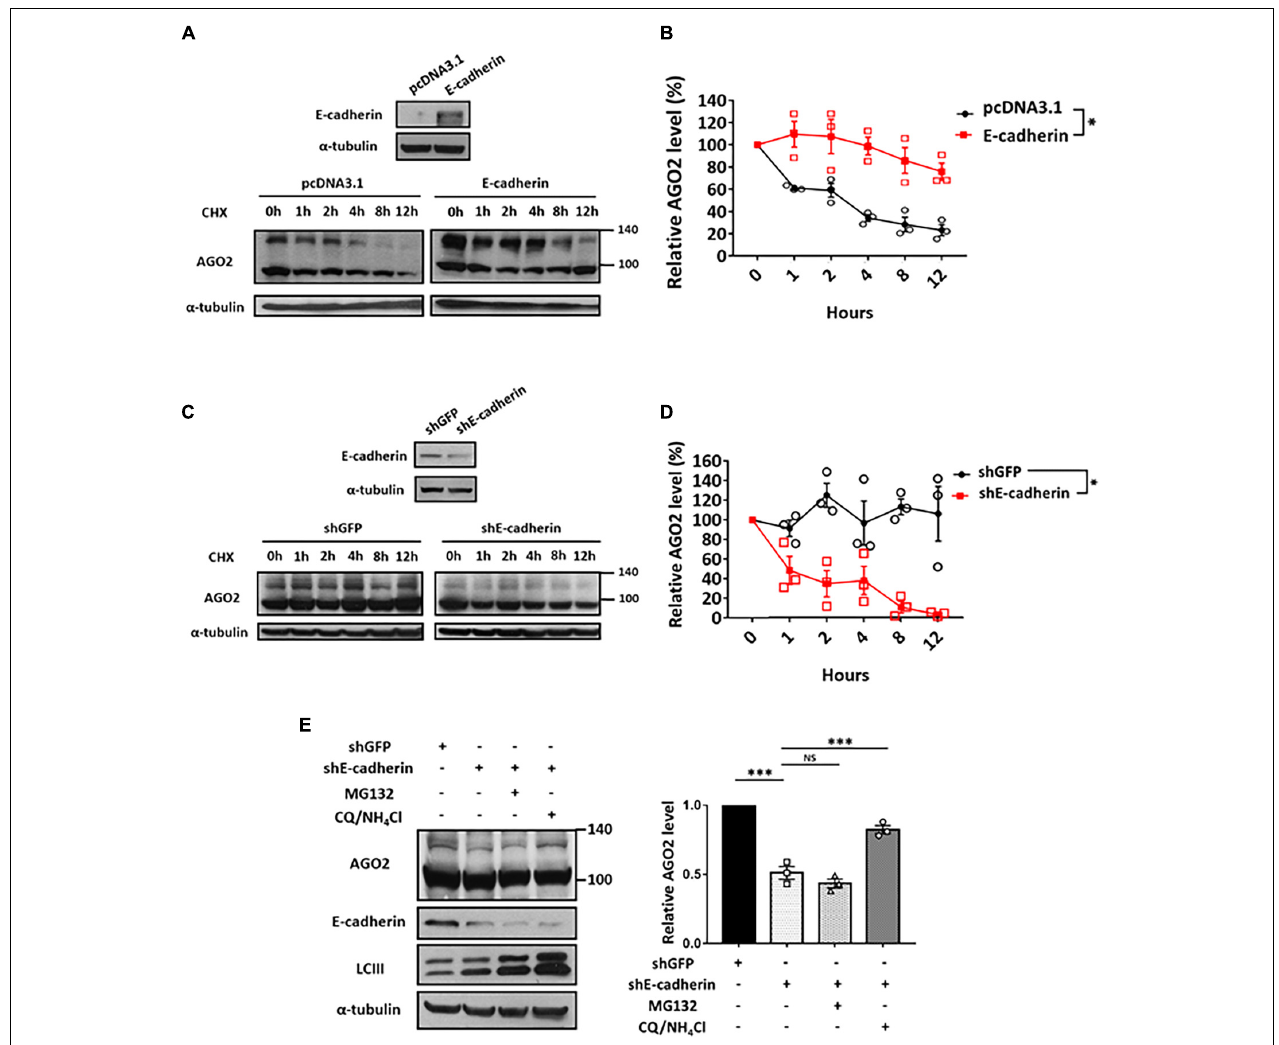
FIGURE 3 | Lysosomal degradation of AGO2 protein is alleviated by E-cadherin. Determination of AGO2 protein stability in E-cadherin-overexpression and knockdown cells (A-D) . E-cadherin-overexpressing HeLa cells (A,B) or E-cadherin knockdown MCF-7 cells (C,D) were treated with 50 µ g/mL of cycloheximide to block de novo protein synthesis and collected at indicated time points for determining AGO2 protein expression by western blot. (B,D) Degradation curves were plotted based on the quantification results of upshifted band of AGO2 from at least three independent experiments (mean ± SEM) and statistically analyzed by two-way ANOVA. ∗ p ≤ 0.05. (E) Effect of MG132 and CQ/NH 4 Cl treatments on AGO2 expression in E-cadherin knockdown cells. 5 µ M MG132 or 40 µ M CQ/10 mM NH 4 Cl were treated for 24 h in E-cadherin knockdown cells. Repeated data of panel (E) (upshifted band of AGO2) were quantitated using image J and repeated at least in three independent experiments (mean ± SEM) and statistically analyzed by one-way ANOVA. ∗∗∗ p ≤ 0.001. NS means no